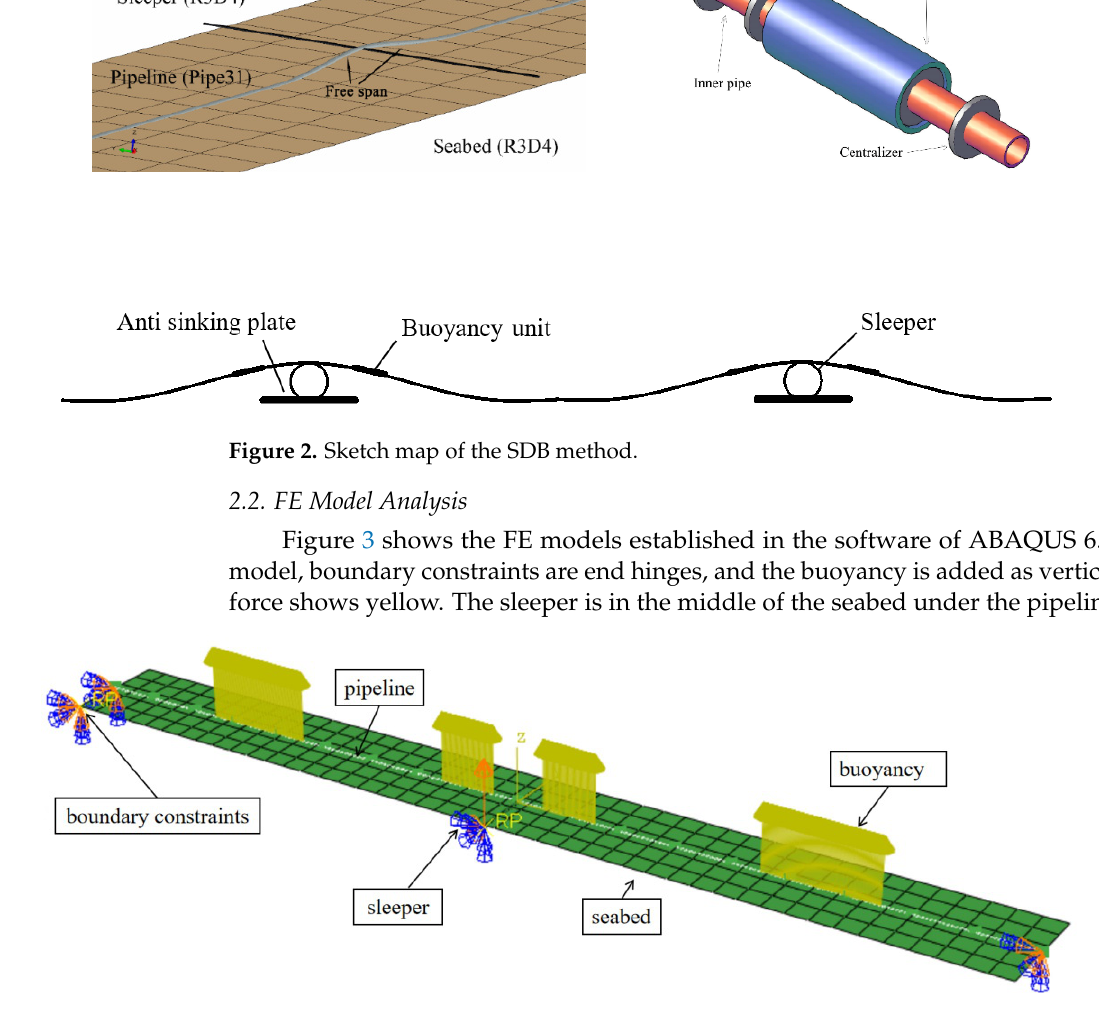
Figure 3. FE model of SDB.